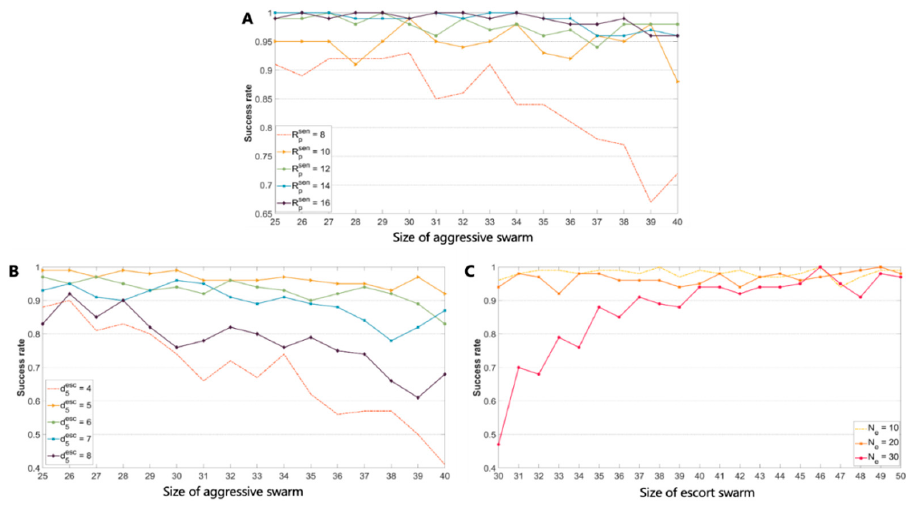
Figure 8. Sensitivity analysis of the bilateral cooperative escort method. ( A ) HVU’s perception range. ( B ) Radius of escort potential field. ( C ) Swarm size of both sides. ( B ) Radius of escort potential field. ( C ) Swarm size of both